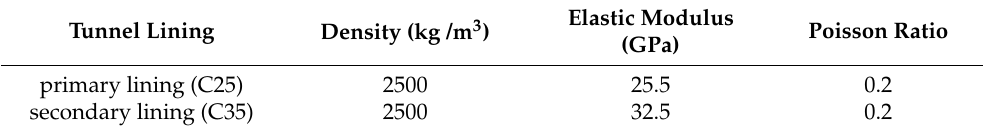
Figure 1. Tunnel configuration ( a ) distribution of soil layers ( b ) the direction of the longitudinal axis of the tunnel ( c ) the shape of tunnel section ( d ) reinforcement configuration of tunnel. Table 1. Tunnel mechanics parameters.